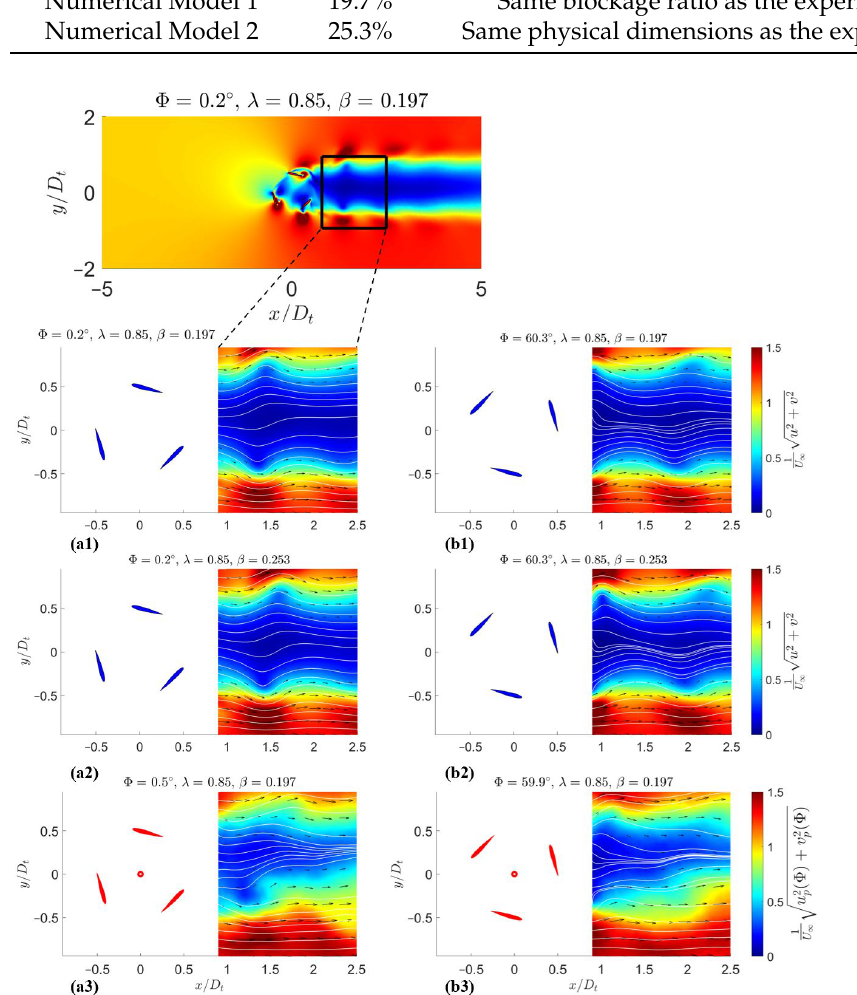
Figure 6. The numerical (blue turbine) and experimental (red turbine) near-wake results. The CFD flow pictures are instantaneous snapshots at 2 phase angles after the convergence criterion was satistfied ( a1 , a2 , b1 , b2 ). The experimental pictures are the phase-averaged results discussed in [16] at the relevant phase angle ( a3 , b3